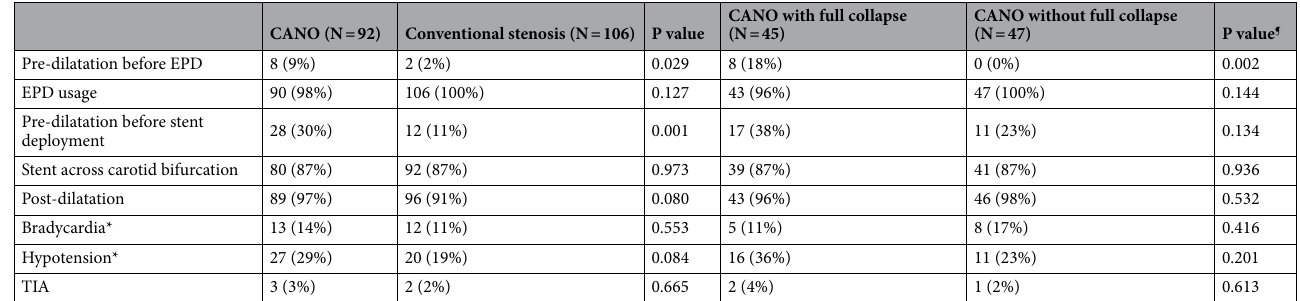
Table 2. Procedural data and events. EPD: distal Embolic protection device; TIA: transient ischemic attack. *Bradycardia and hypotension defined by the needs of chronotropic/vasoactive agents use after stenting. ¶ P value of comparing CANO patients with and without full